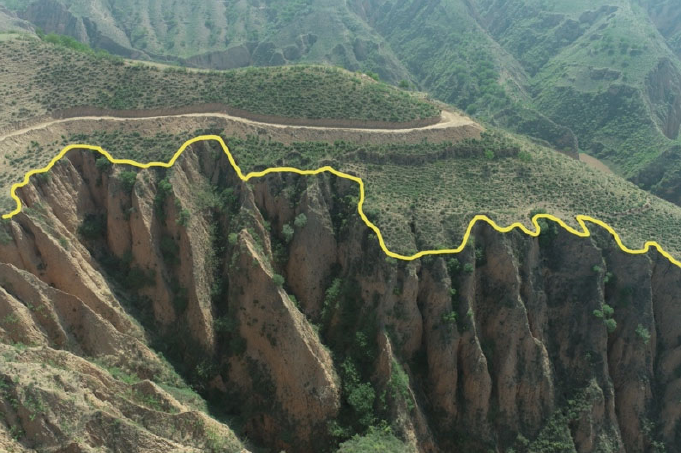
Figure 2. Location of the shoulder-line in the Loess Plateau of China.